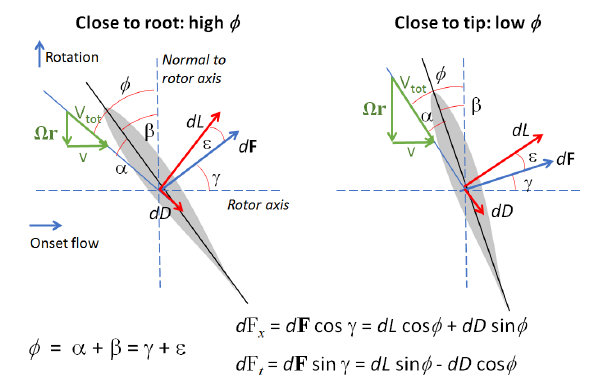
Fig. 2. Inflow and elementary load contributions at representative blade sections at root (left) and tip (right). Design requirements for maximum power and lim-